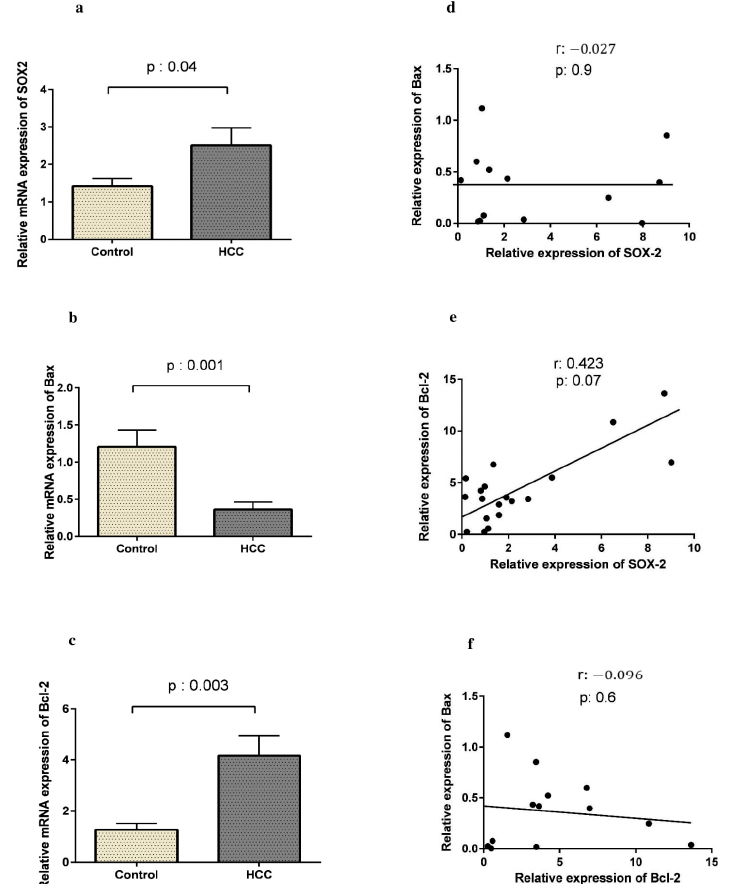
Figure 1. Relative expression of SOX2, Bax, and Bcl-2 in HCC patients and controls by 2 − ∆∆ CT method; qRT-PCR analysis showed an up-regulation of SOX2 ( a ) as well as down-regulation of Bax ( b ), and up-regulation of Bcl-2 in HCC patients ( c ). There was no correlation between Bax and SOX2 expression ( d ), a positive correlation was found between Bcl-2 and SOX2 expression in patients ( e ). There was no correlation between Bax and Bcl-2 expression ( f ). Since hepatitis B virus (HBV) and/or hepatitis C virus (HCV) infection is the most important risk factor for HCC establishment, we further classified HCC patients into HBV or HCV positive or negative groups. As shown in Table 4, there was no significant associ- ation between infection with HBV or HCV and the expression of SOX2, Bax, or Bcl-2 in HCC patients.